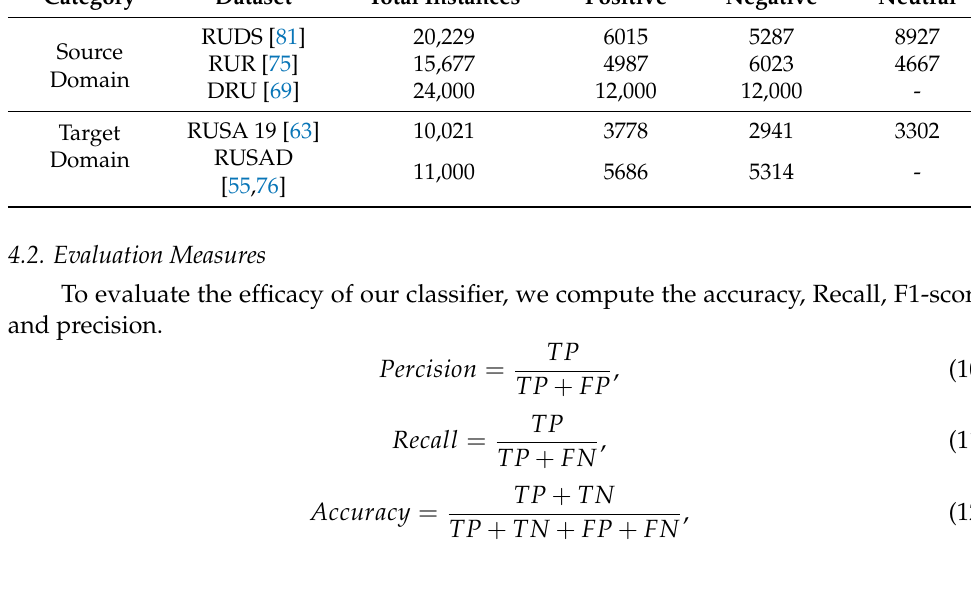
Table 2. Dataset